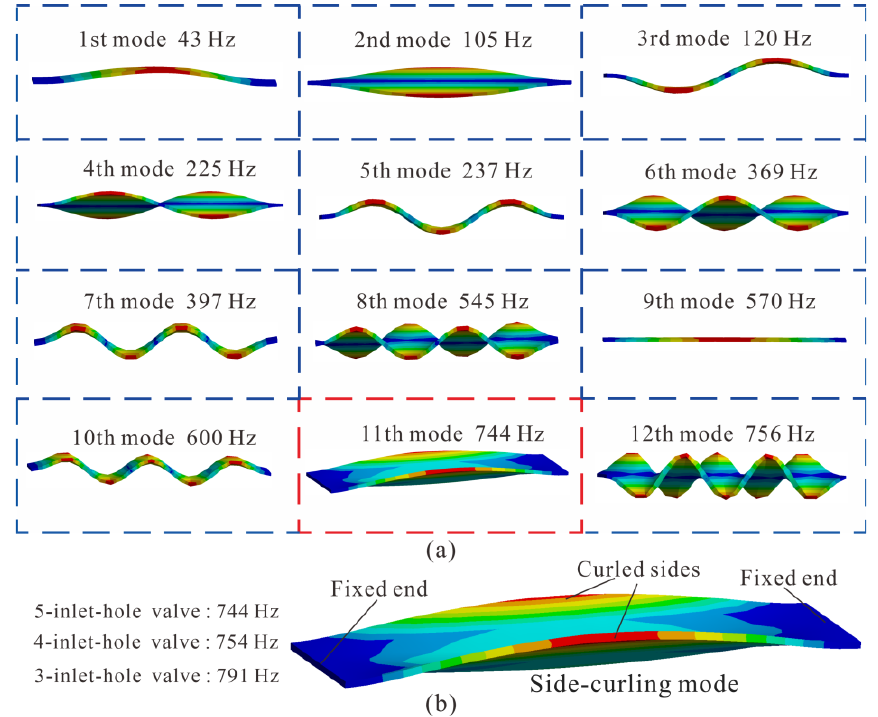
Figure 2. ( a ) The first 12 wet modes of the five-inlet-hole polydimethylsiloxane (PDMS) valve; ( b ) enlarged diagram of the side-curling mode. Table 1. Parameters of the piezoelectric resonator and the check valve.